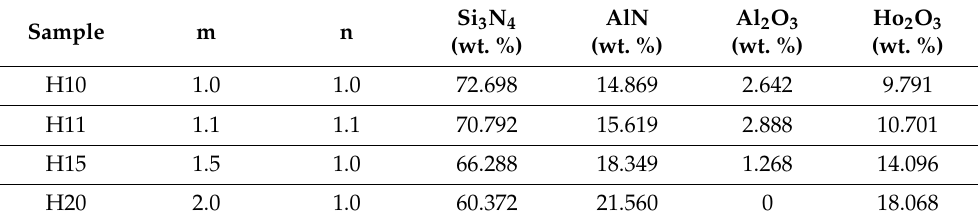
Table 1. Starting m and n parameters, precursor compositions, and sample codes of the synthesized SiAlON